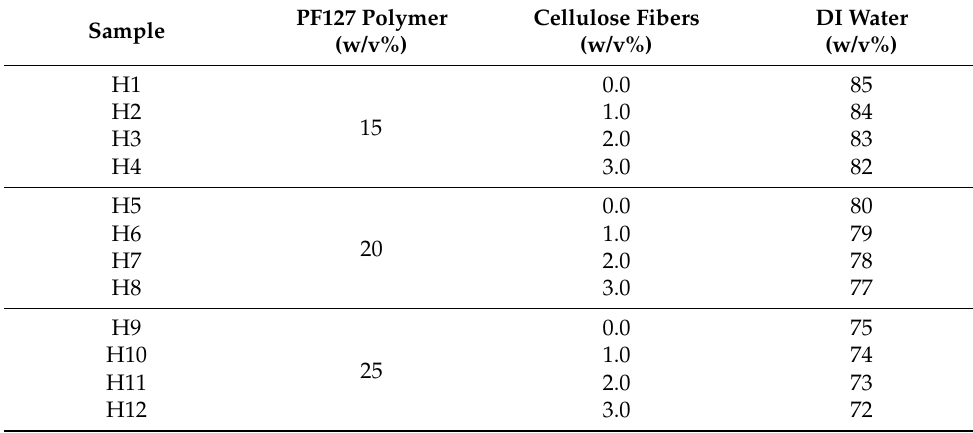
Table 1. Formula of thermo-responsive cellulose